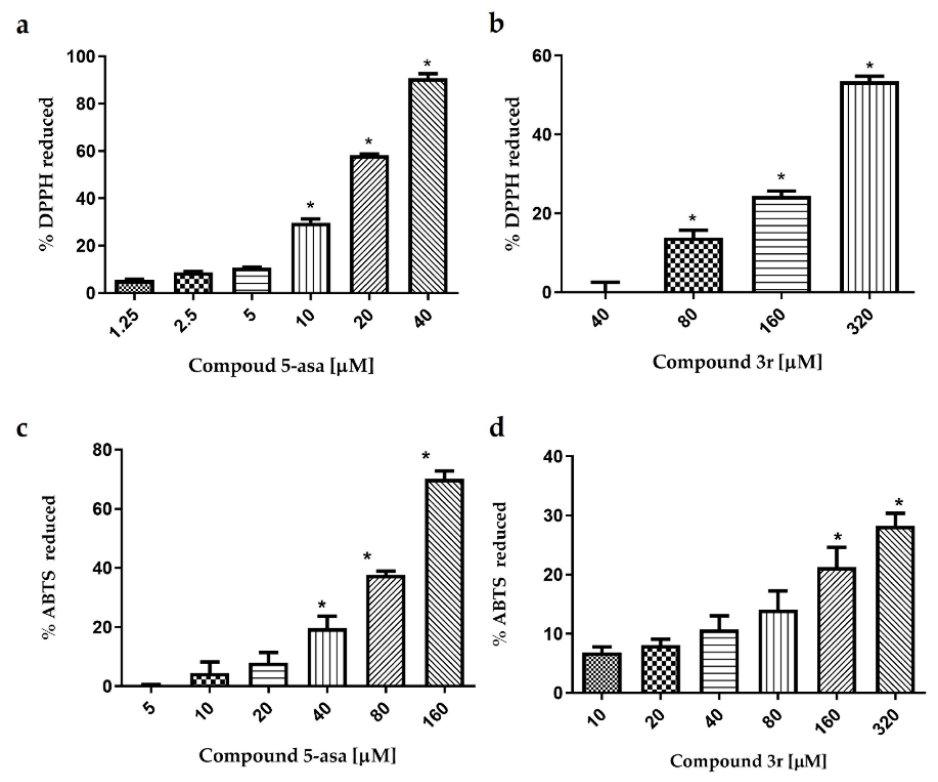
Figure 7. Antioxidant activity by DPPH and ABTS. ( a ) Percentage of DPPH reduced by 5-asa and; ( b ) 3r . ( c ) Percentage of ABTS reduced by 5-asa and; ( d ) 3r . The experiment was performed in triplicate in two independent experiments. * Indicate significant difference p < 0.05 between each concentration and the less concentration.